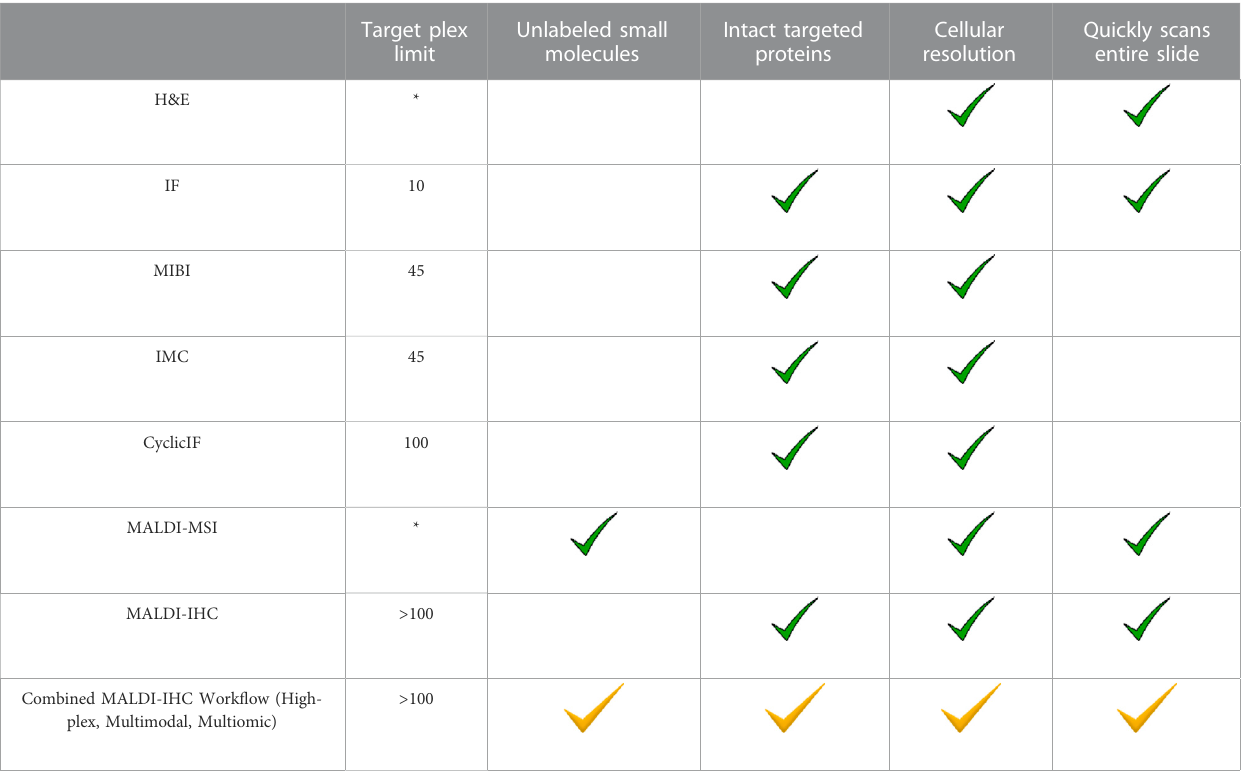
TABLE 1 Comparison of the major features of various multiplex tissue imaging methods with focus on top-down targeted imaging of intact proteins. “ * ” denotes imaging methods which are intrinsically bottom-up and do not target speci fi c intact proteins. For example, MALDI-MSI is normally used for untargeted detection of small molecules including protein proteolytic fragments. Note that the last row with yellow check marks combines features of MALDI-MSI and